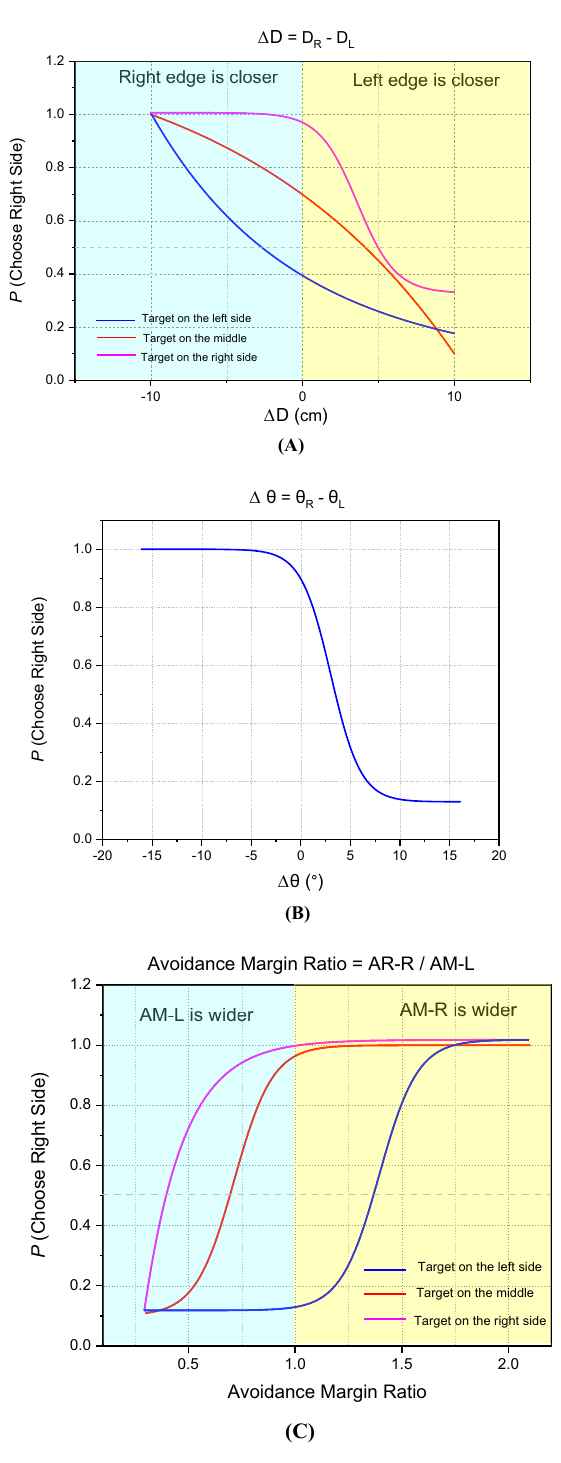
Figure 4. Probability of walking to the right side of the obstacle based on the target and obstacle locations. ( A ) Influence of ΔD on the probability of walking to the right of the obstacle. ( B ) Influence of Δθ on the probability of walking to the right of the obstacle. ( C ) Influence of avoidance margin on the probability of walking to the right of the